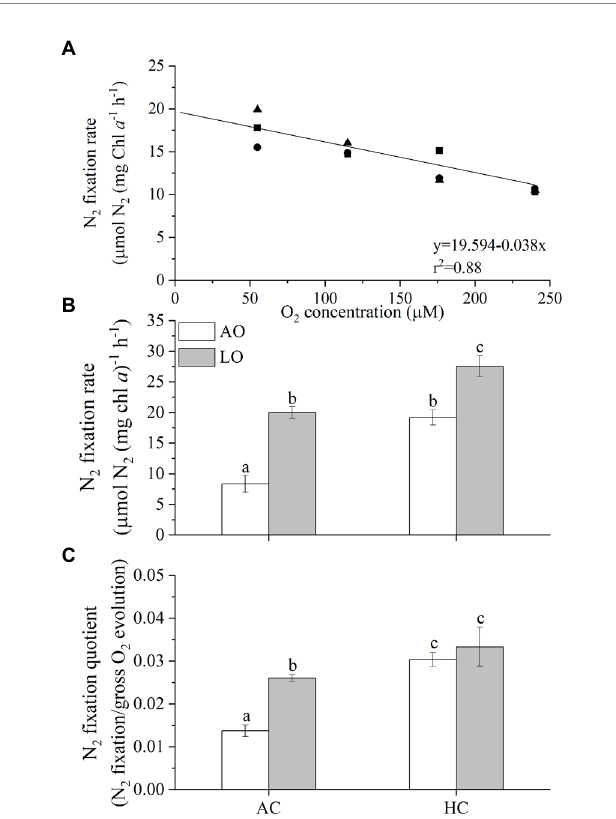
FIGURE 3 (A) N 2 -fixation rates of T . erythraeum IMS101 as a function of dissolved O 2 concentrations in cultures after the cells acclimated for 48 h, (B) the N 2 -fixation rates and (C) N 2 -fixation quotients of T . erythraeum cells after acclimated different levels of O 2 and CO 2 (see Figure 1) for 32 days (24 generations). Different symbols [panel (A) ] represent independent cultures ( n = 3). The values in panels (B,C) indicate the means ± SD for triplicate cultures at each treatment. Levels of p CO 2 and p O 2 are the same or within the same ranges as shown in Figure 1. Different letters above the bars indicate significant ( p < 0.05) differences among the